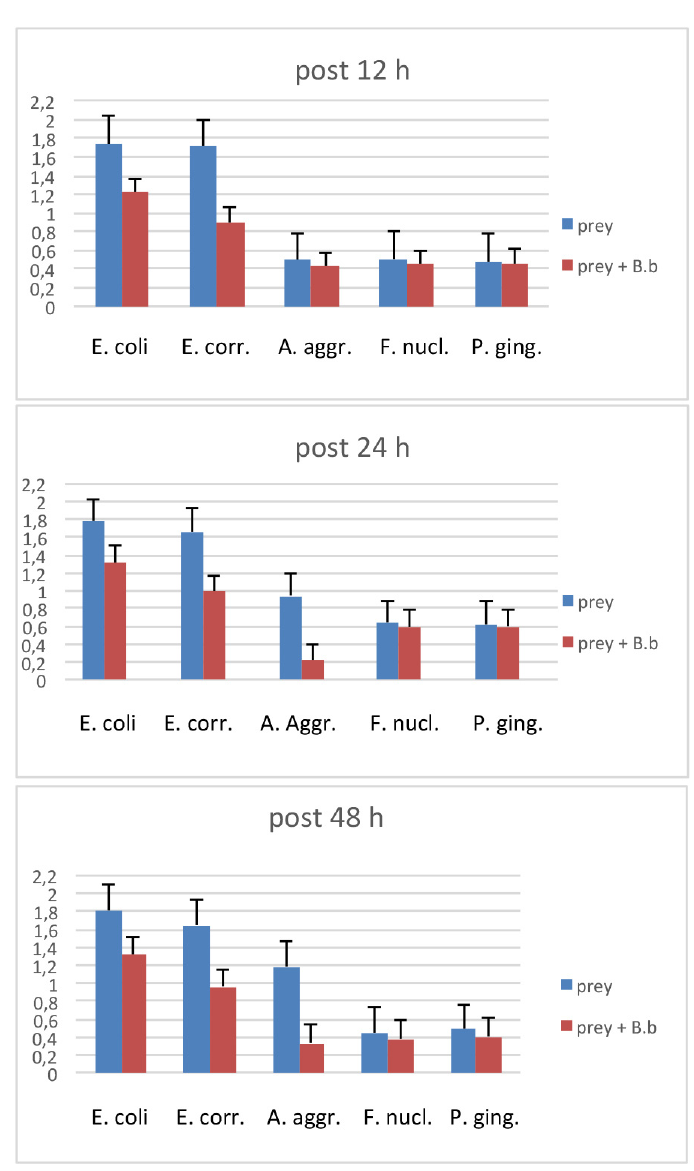
Figure 6. Difference of bacterial growth rate between positive controls and co-cultures at 12 h, 24 h and 48